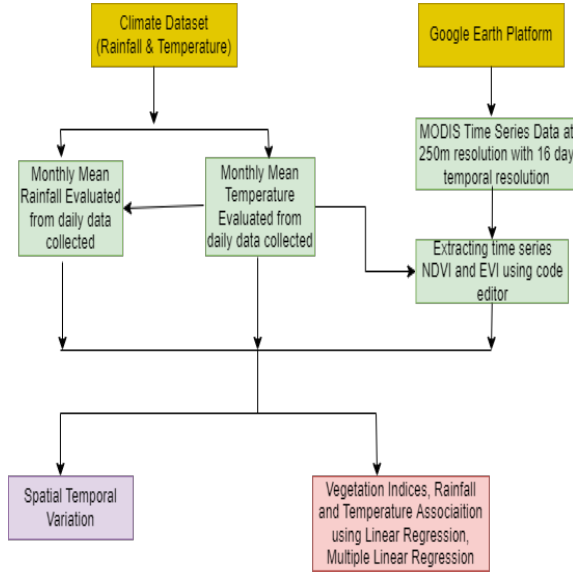
Figure 2. Methodology